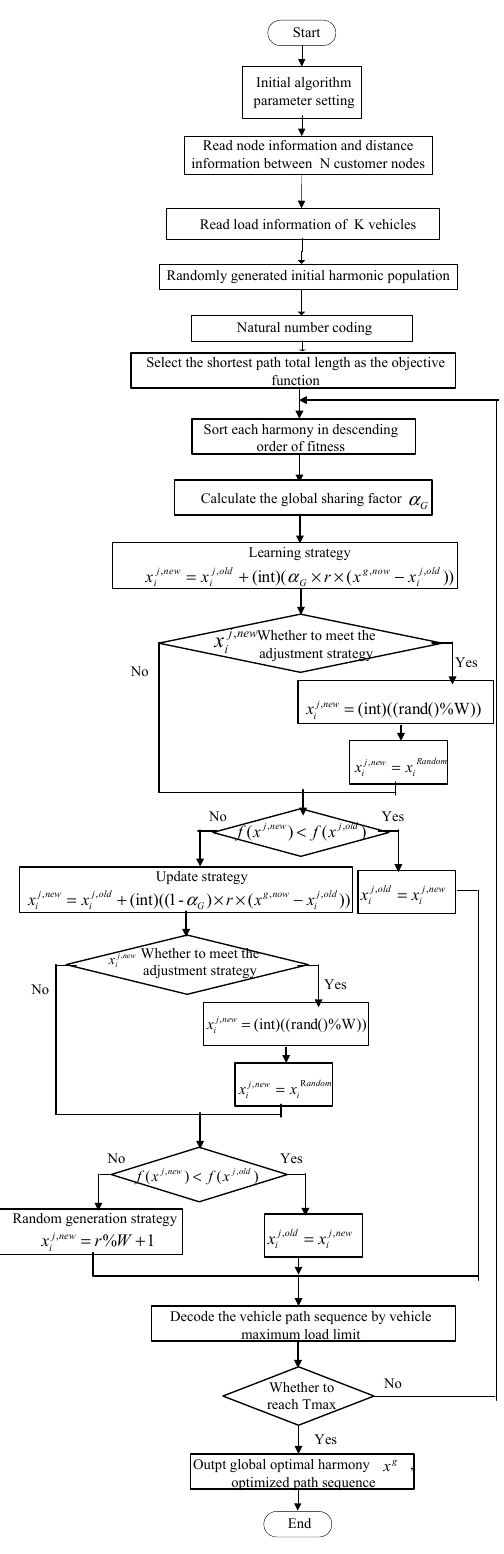
Figure 1. Flowchart of Harmony Search method with Global Sharing Factor based on natural number coding and decoding for Vehicle Routing Problem (GSF-HS-VRP) algorithm.